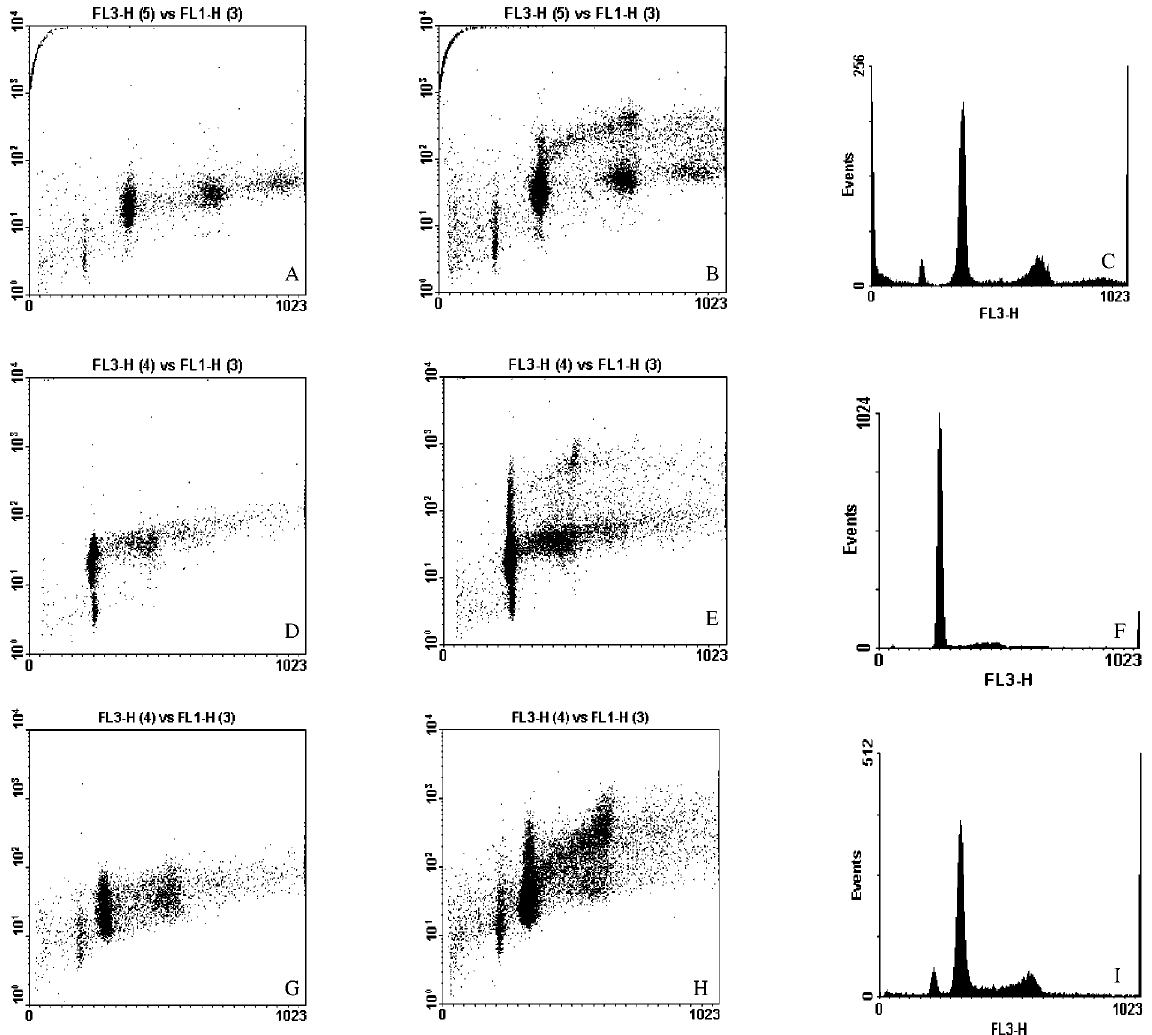
Fig. 2. Examples of bivariate MIB-1/DNA FCM analyses. Dot-plots relate to MIB-1 expression (FL1-H) versus DNA content (FL3-H). Figures A, B, C refer to isotypic controls; D, E, F to test sample with positivity for MIB-1 of 11, 8 and 28%, respectively; G, H, I to DNA histograms with DIs = 1.77; 1; 1.51,